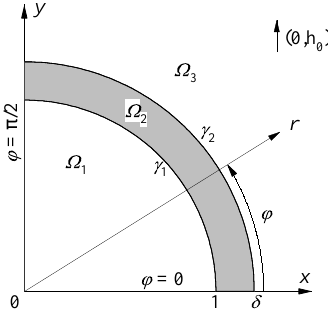
Figure 1. Two-dimensional geometry of the problem under consideration with an internal domain of a cylinder Ω 1 and an external domain Ω 3 , corresponding to nonmagnetic media, and a domain Ω 2 , filled with the